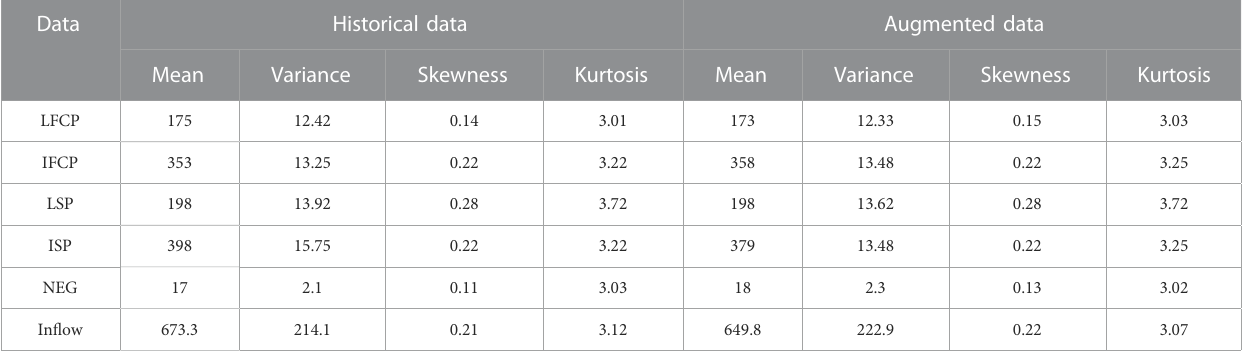
TABLE 2 Statistical indicators of historical data and simulated